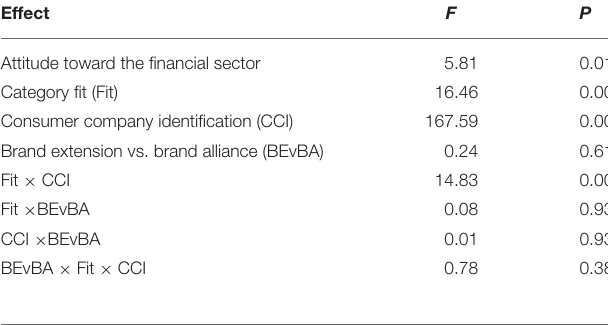
TABLE 4 | Study 1. ANCOVA results for purchase intention.